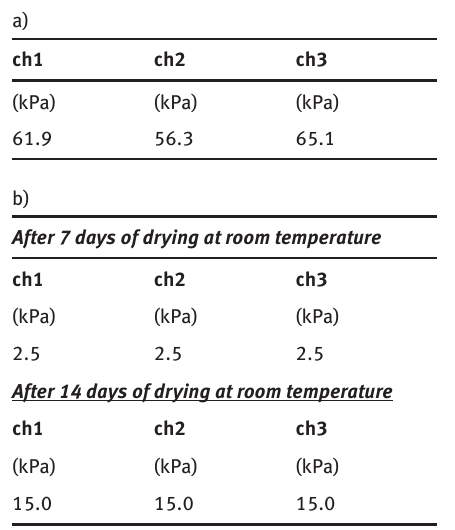
Table 4: Matric suction values measured along the central vertical of the prototype model: a) at initial state; b) during the drying